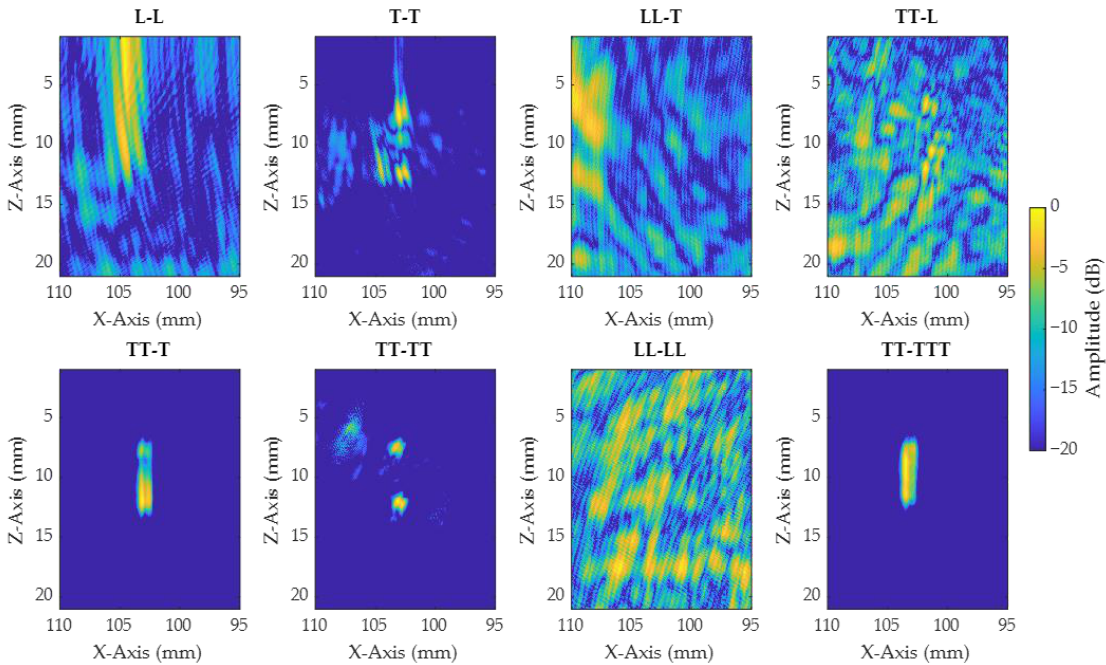
Figure 12. TFM algorithm applied to different views for notch A. The X -axis corresponds to the lateral distance from the wedge and the Z -axis to the vertical distance in the sample.